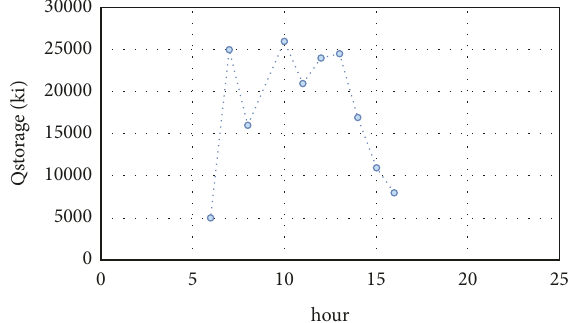
Figure 6: Heat storage tank water temperature changes for each hour of an index day in June.